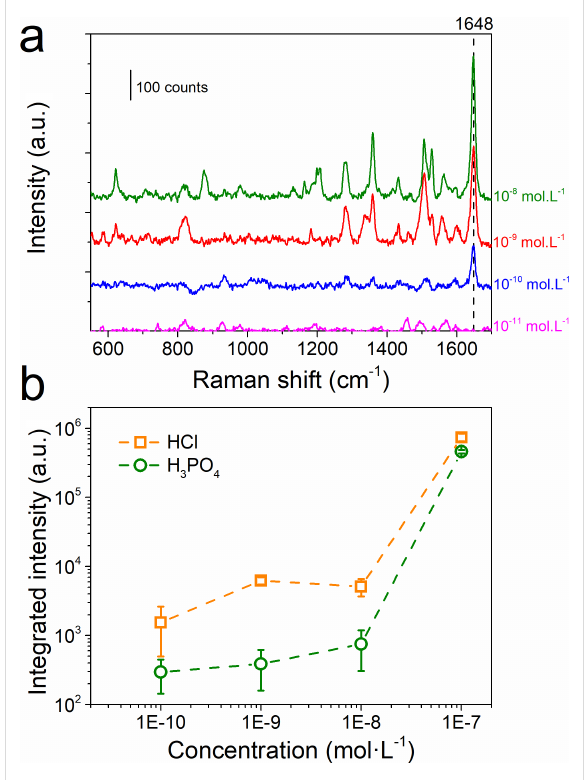
Figure 8: (a) Raman spectra recorded after 24 h of incubation in a RhB solution for different concentrations on a sample with an initial amount of silver of 30 atom % and dealloyed for 60 min in 1 wt % of HCl. (b) Comparison of the evolution of the integrated peak at 1648 cm − 1 for different concentrations of RhB for samples with 30 atom % of silver at the initial state and dealloyed for 60 min in (orange) 1 wt % of HCl and (green) 10 wt % of H 3 PO 4